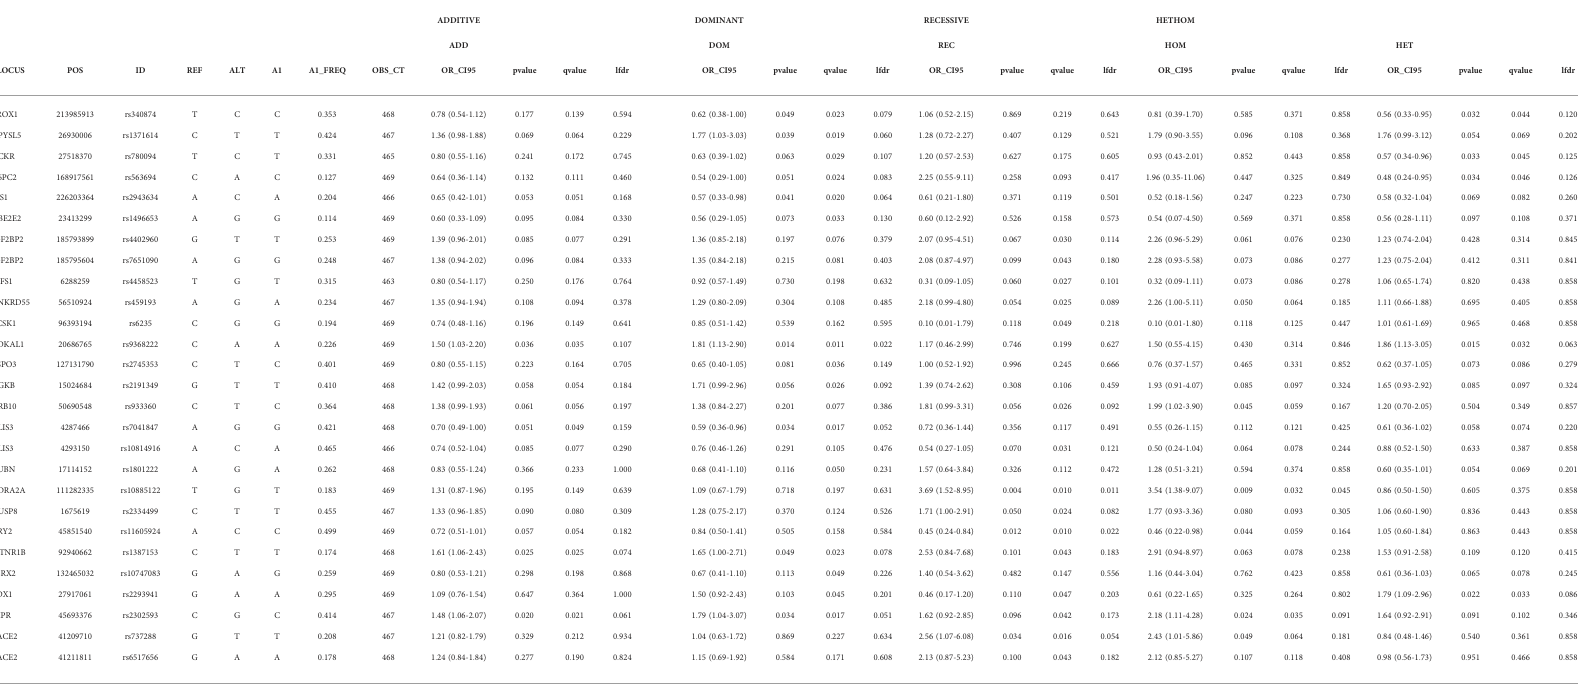
TABLE 3 HIS (SNP + GROUP) MODELS. SIGNIFICANT SNPs. HISPANIC.